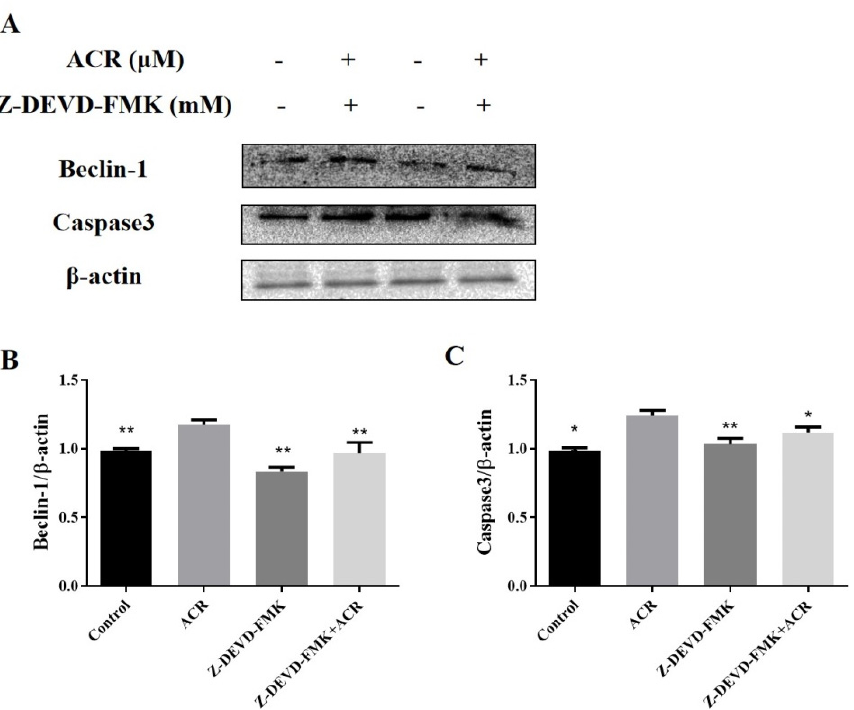
Figure 10. Apoptosis inhibitor attenuated autophagy. ( A ) The protein levels of caspase-3 and Beclin 1 proteins. ( B , C ) Relative intensities of these proteins. Values are means ± SD ( n = 3), * p < 0.05, ** p < 0.01 compared to ACR group.